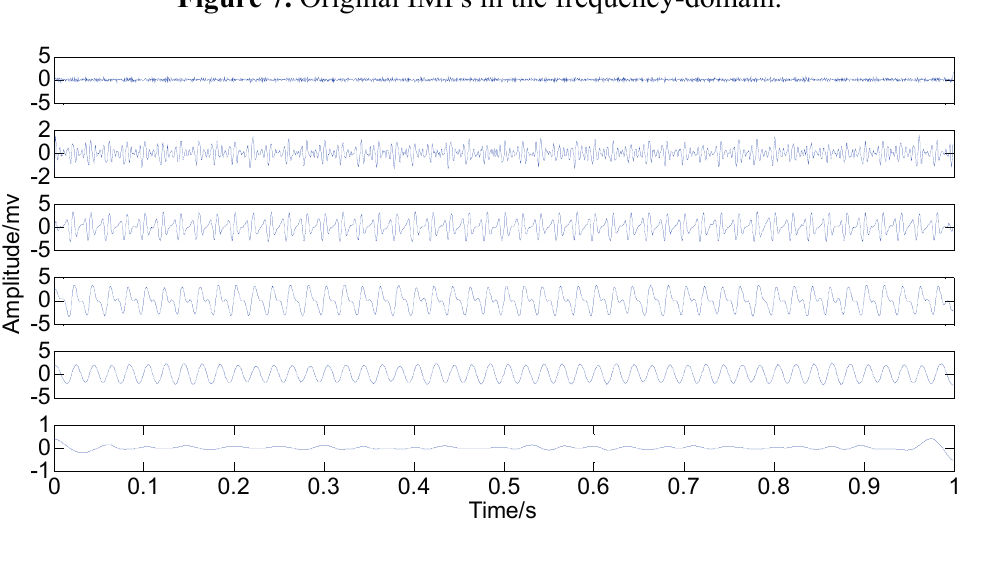
Figure 8. Optimized IMFs in the time-domain.